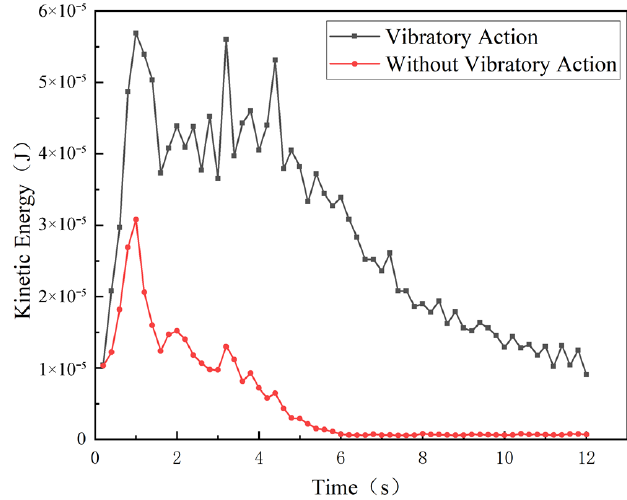
Figure 9. Kinetic energy simulation curve diagram.